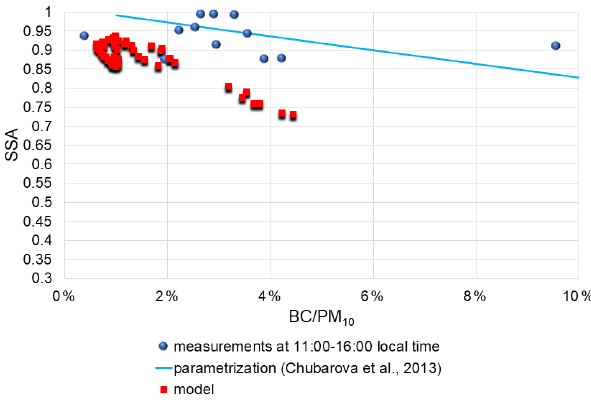
Figure 7. Single-scattering albedo in the visible spectral region as a function of the BC / PM 10 ratio according to model simulations and measurements within 3h around local noon and linear regression obtained from observations in Chubarova et al. (2013). Clear-sky